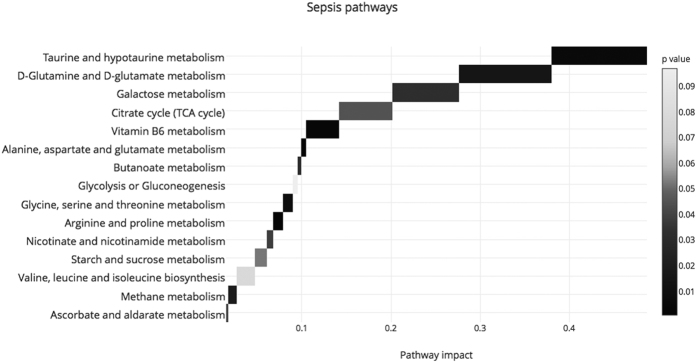
Higher impact pathways involving significant metabolites of both techniques as resulted from the online web software MetaboAnalyst.The significance of a model increases in the y-axis. The color bar indicates the p-value of the pathway; darker color corresponds to more significant p-value (smaller value).